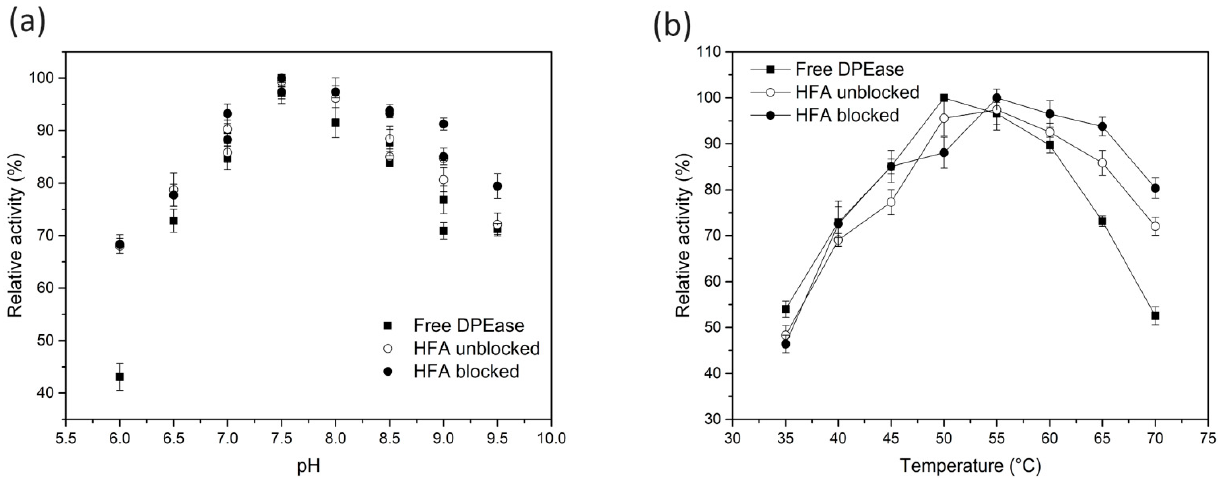
Figure 5. Optimum ( a ) pH and ( b ) temperature of free, unblocked, and blocked